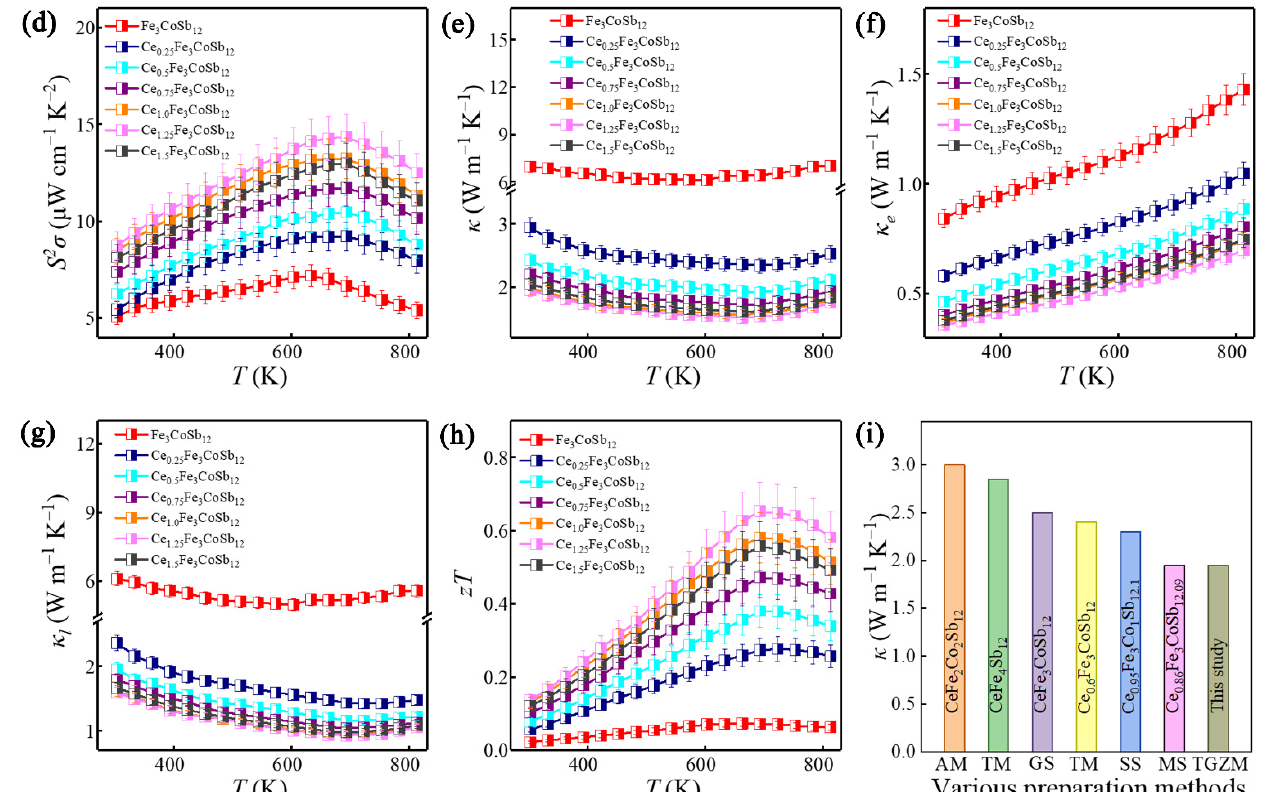
Figure 5. Thermoelectric properties of Ce x Fe 3 CoSb 12 (x = 0 to 1.5). Temperature-dependent ( a ) σ ; ( b ) S . ( c ) The experimental S values corresponding to the n H , where the red line represents the Pisarenko plot for Fe 3 CoSb 12 . Temperature-dependent ( d ) S 2 σ ; ( e ) κ ; ( f ) κ e ; ( g ) κ l ; ( h ) zT . ( i ) Comparison of the room-temperature κ for nominal Ce 1.25 Fe 3 CoSb 12 with the reported